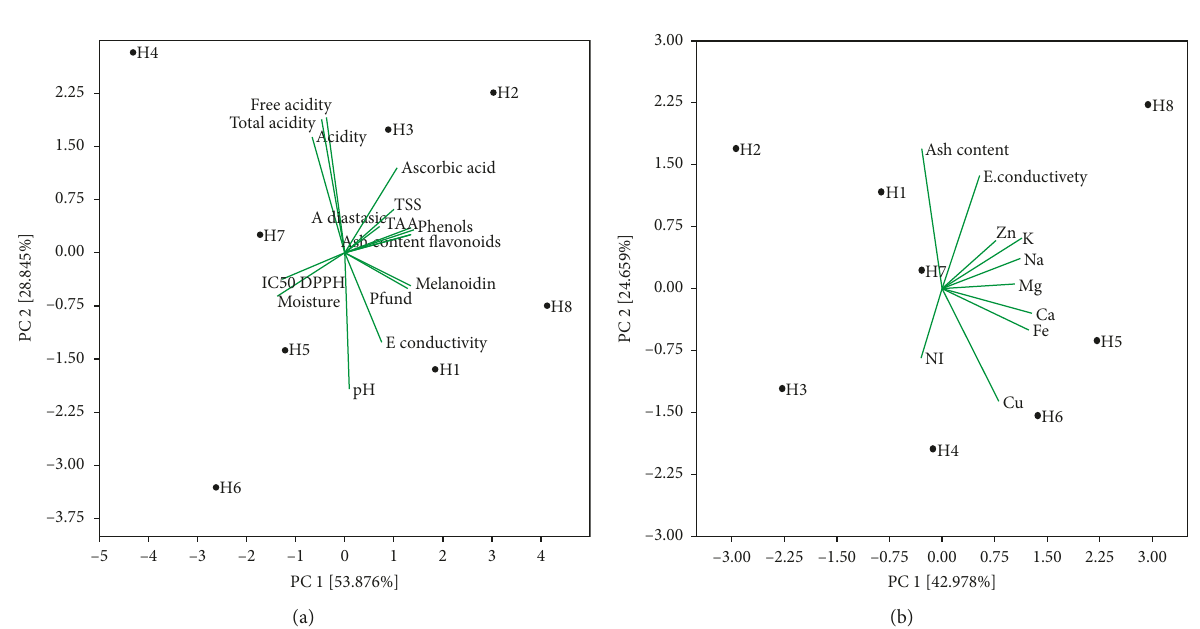
Figure 2: Principal component analysis: (a) biplots of honey samples using physicochemical parameters and the antioxidant activities. (b) Biplots of honey samples using electrical conductivity, ash, and mineral content.